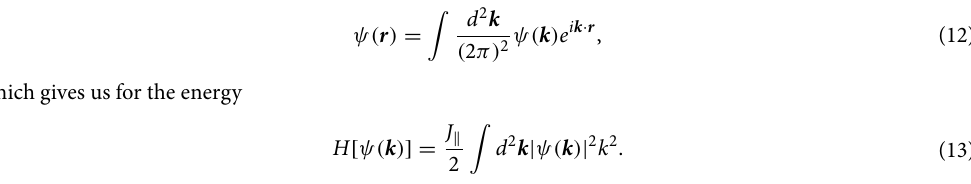
Figure 3. Ratio of eigenvalues [Eq. (7)] (cid:31) chemical field K